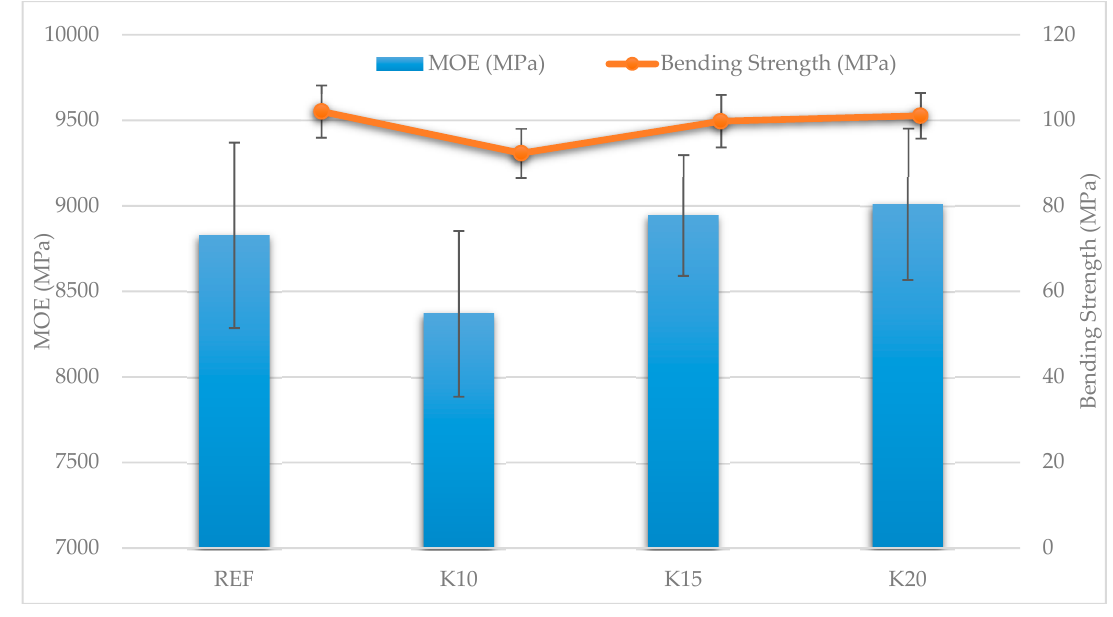
Figure 6. Effect of adhesive mixtures on bending strength and modulus of elasticity of plywood panels.